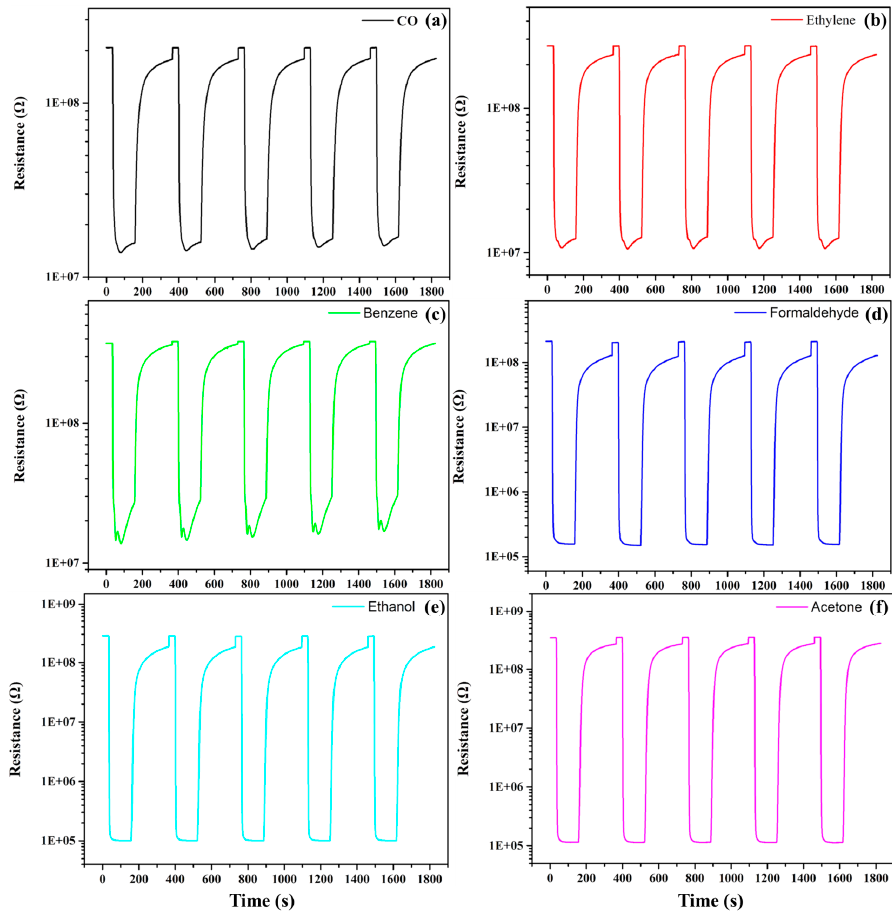
Figure 6. The Resistance–Time (R–T) curves of SnO 2 + 0.5 Ir mol% to 100 ppm of the six gases at 350 °C.